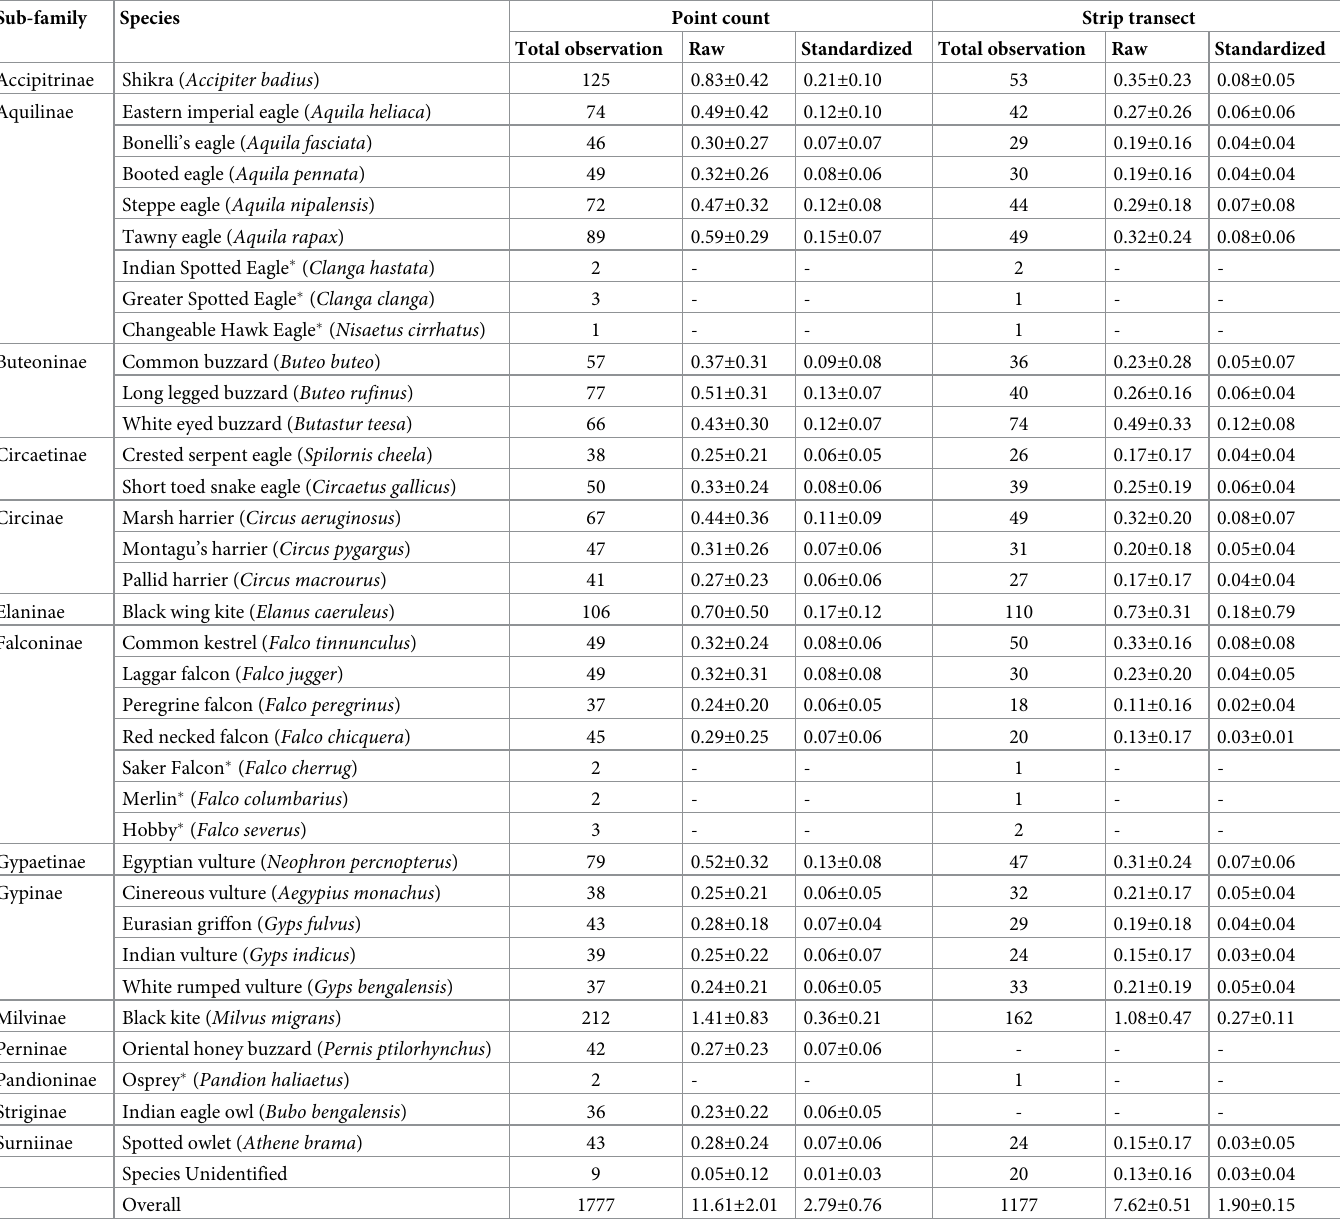
Table 1. Estimated abundance of raptors from roadside point count and strip transect methods in the arid region of Rajasthan.